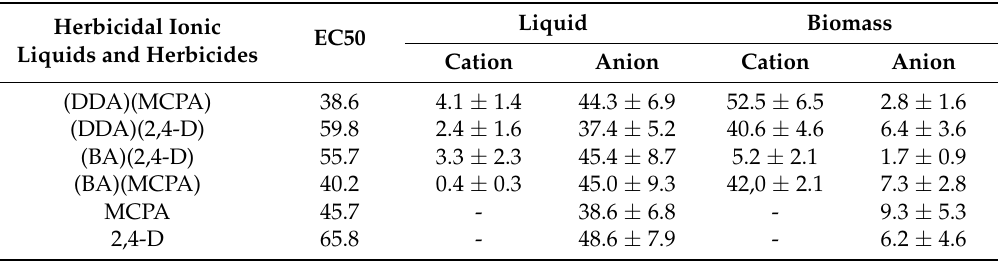
Table 3. EC50 values and concentration (mg/L) of HILs in the supernatant and biomass given as mean values, standard deviations of the